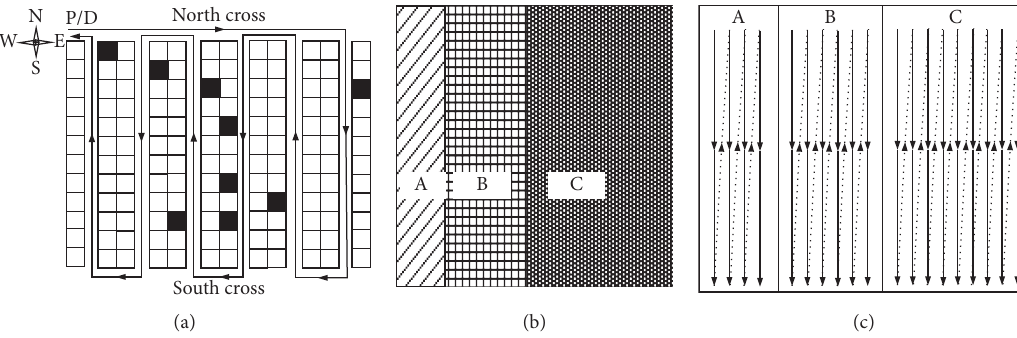
Figure 2: Assignment strategy of DSLA: (a) traversing routing method, (b) within-aisle storage, and (c) order of the storage